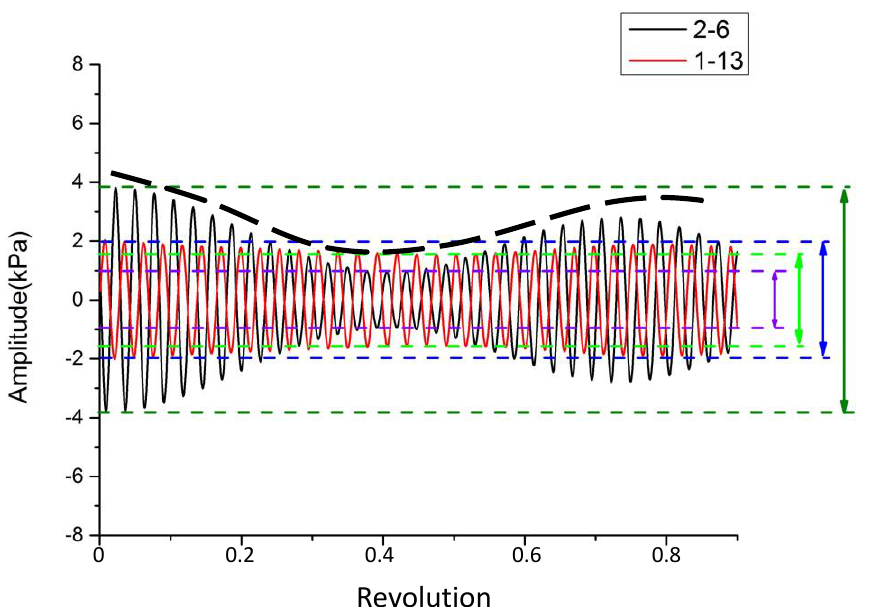
Figure 15 . The comparison of the 1BPF disturbance of the R1 blade sweep between locations 1-13 and 2-6 .